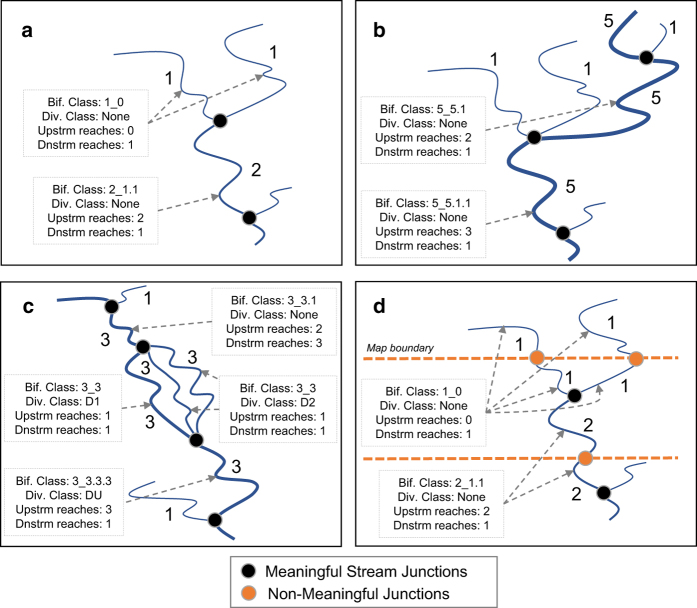
Conceptual diagram of various scenarios of stream network bifurcation and divergence.For each scenario, reaches are labeled according to their Strahler stream order. Bifurcation (Bif.) classes, divergence (Div.) classes, and the number of upstream and downstream reaches are noted. Naturally-occurring (i.e. meaningful) stream junctions are distinguished from non-meaningful stream reach junctions arising from quadrangle map boundaries. Scenarios include (a) a common, simplified stream junction, (b) a more complex junction with more than 2 upstream contributing reaches, (c) a situation of stream divergence, and (d) non-meaningful stream junctions arising from map boundaries. In the case of (d), reaches immediately occurring downstream of non-meaningful junctions are assigned to the same class as their upstream neighboring reach.